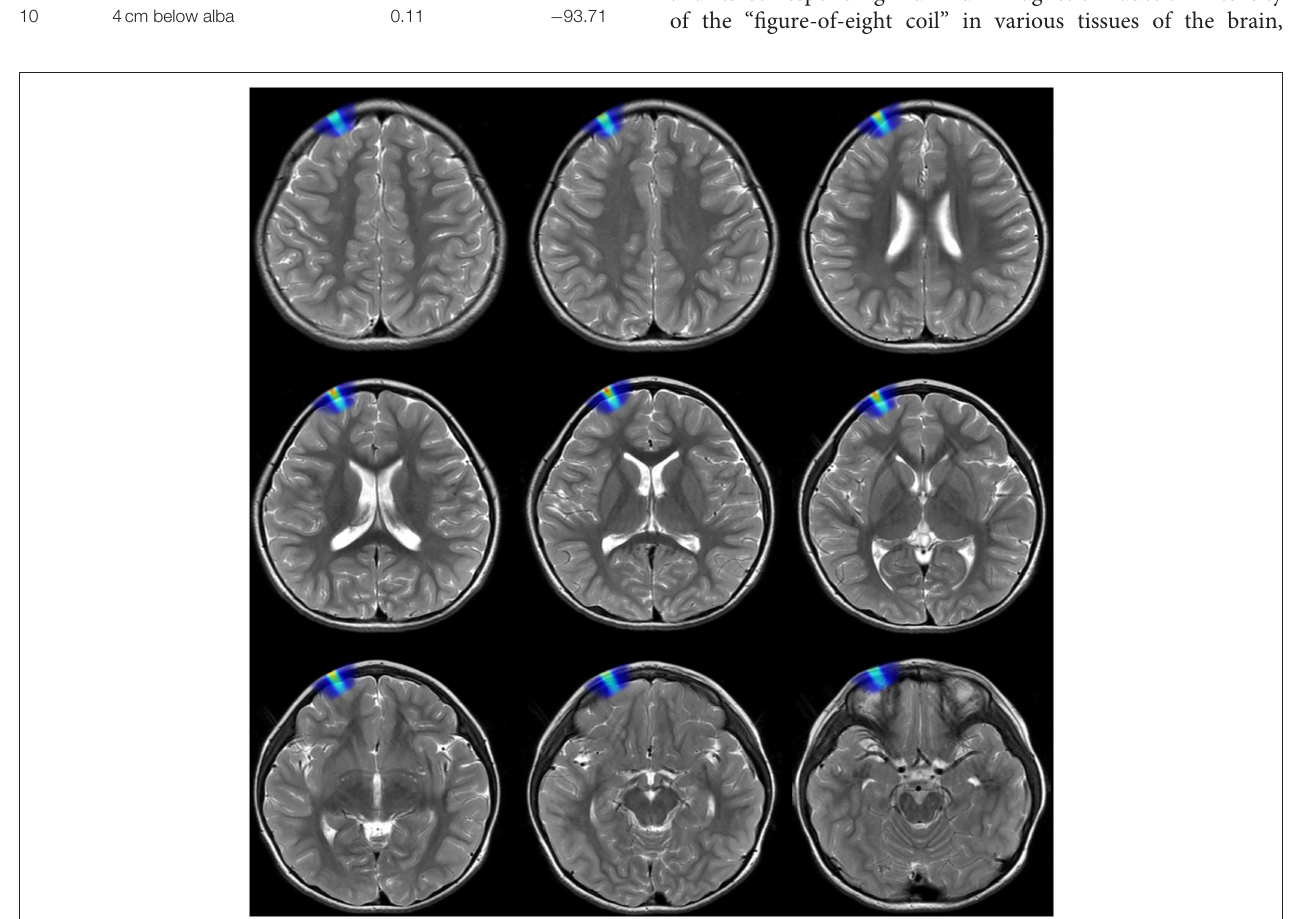
Frontiers in Neuroscience |